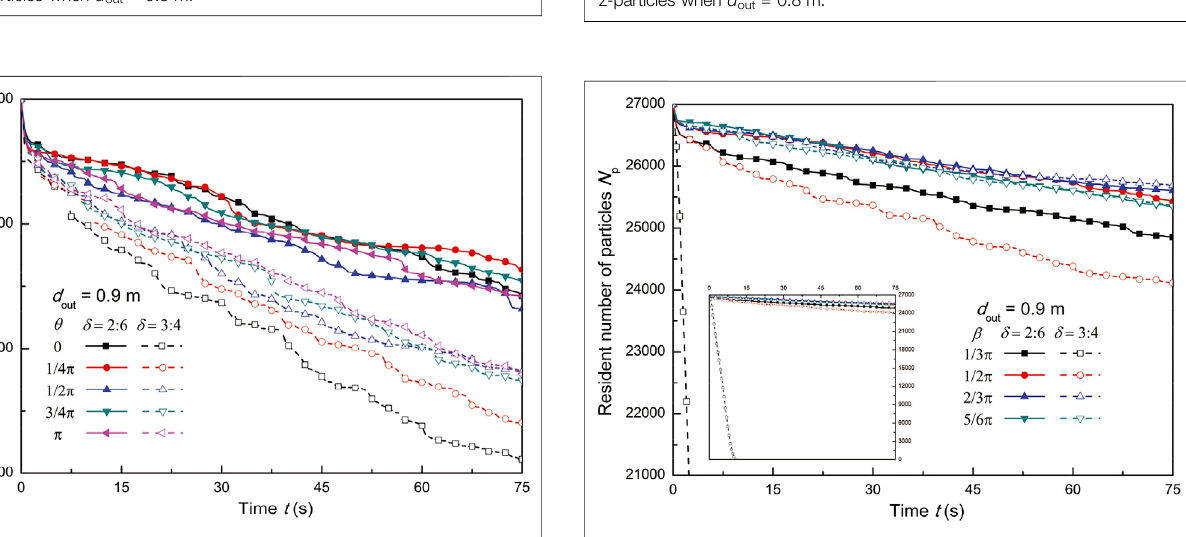
FIGURE 6 | Discharging velocity with different included angles θ of z-particles when d out (cid:1) 0.8 m.